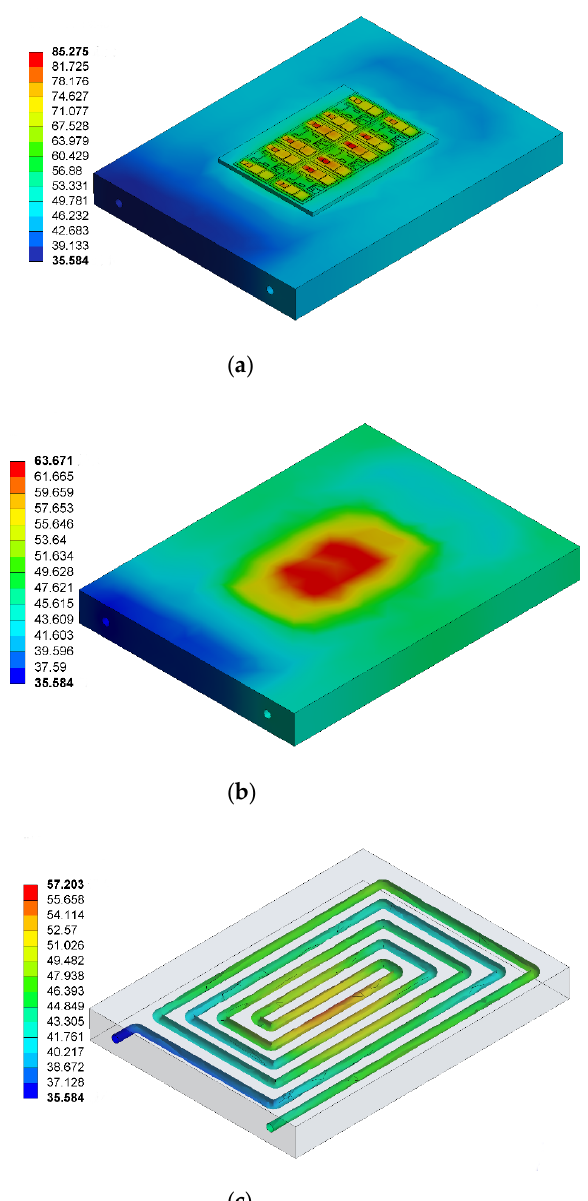
Figure 8. Simulation results ( a ) Overall temperature distribution of the IGBT module, ( b ) Heatsink temperature distribution of the IGBT module, ( c ) Temperature distribution of IGBT water ‐ cooled channel.